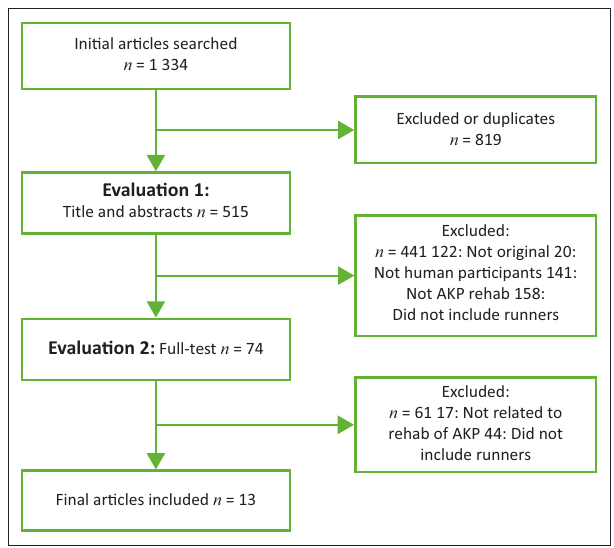
FIGURE 1: Article evaluation flow chart detailing the search